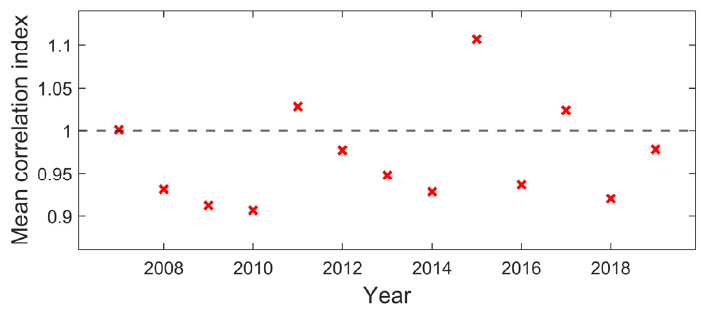
Figure 2. Yearly mean of the ERA5T correlation indices for all 77 sites.